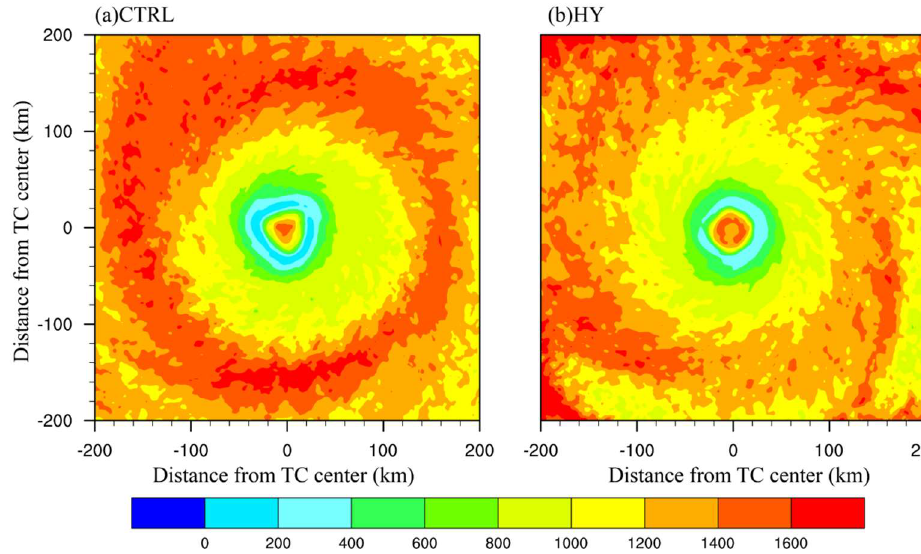
Figure 10. Horizontal distribution of the simulated maximum CAPE for ( a ) CTRL and ( b ) HY.